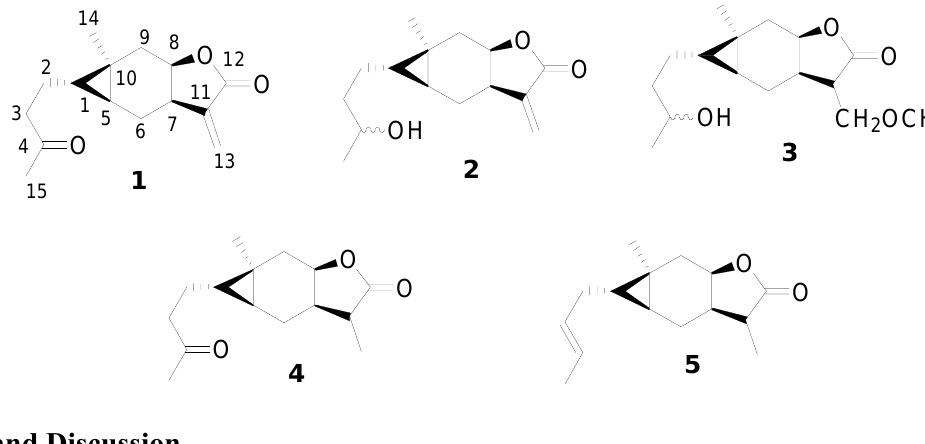
Figure 1. The chemical structures of carabrone and its